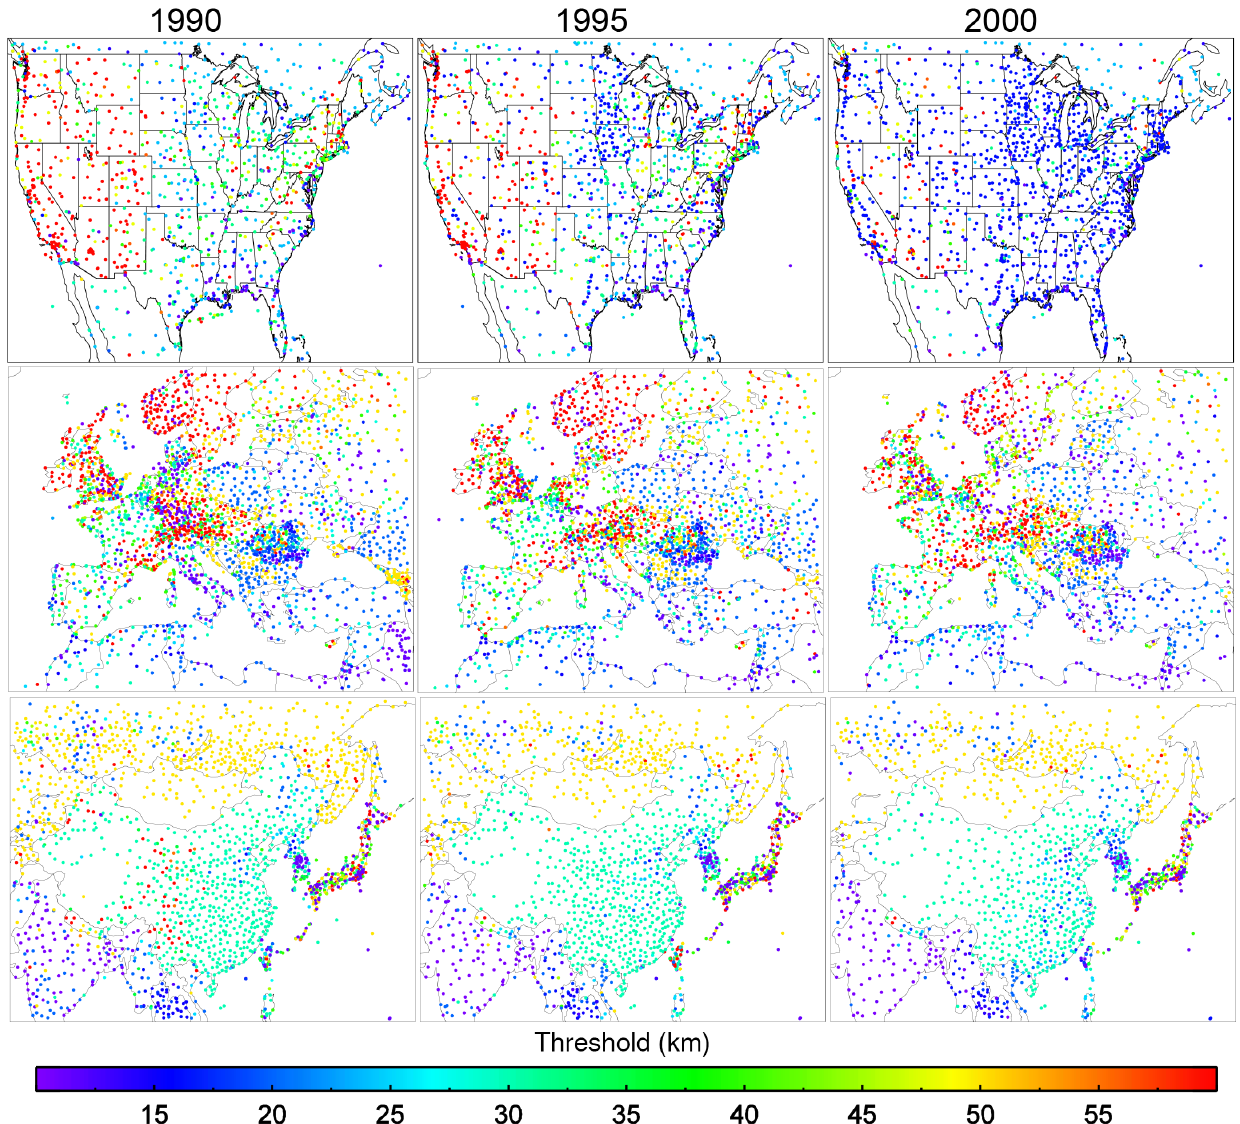
Figure A1. Threshold visibility of ISD stations over the US, Europe and eastern Asia in 1990, 1995 and